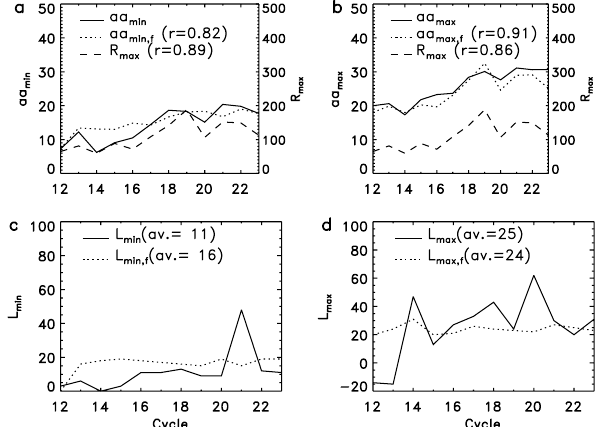
Fig. 4. The observed (a) geomagnetic minimum ( aa min ), (b) maxi- mum aa ( aa max ), (c) lag times of aa to R z at solar minimum ( L min ) and (d) at maximum ( L max ) for Cycles n = 12–23 are shown by solid lines, and the corresponding values ( aa min , f , aa max , f , L min , f , L max , f ) from the reconstructed series (Eq. 10) are shown by dotted lines. The dashed lines in (a) and (b) show the maximum amplitude ( R max ) of sunspot cycle for comparison. The correlation coeffi- cients of aa min with aa min , f and R max are r = 0 . 82 and 0.89, re- spectively. The correlation coefficients of aa max with aa max , f and R max are r = 0 . 91 and 0.86, respectively.